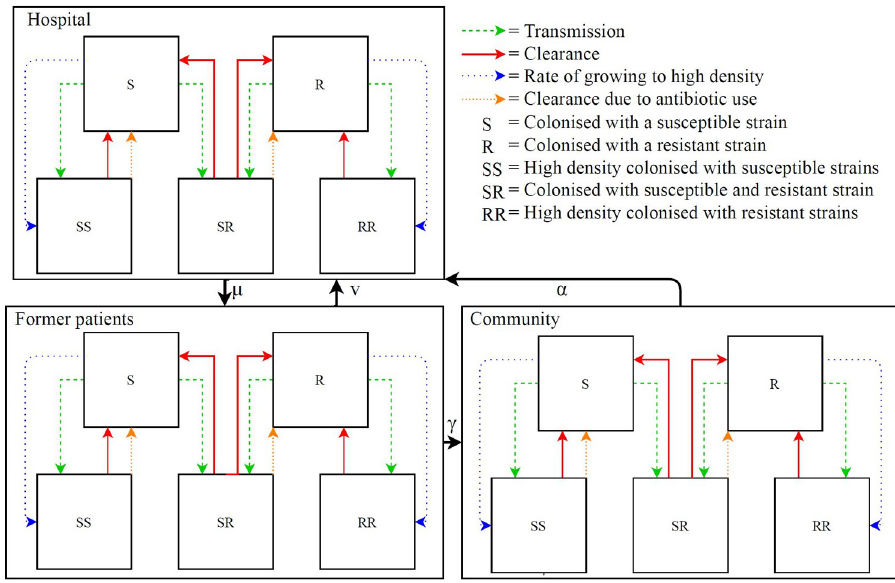
Fig 4. Compartmental model of ESBL E. coli and E. coli colonisation